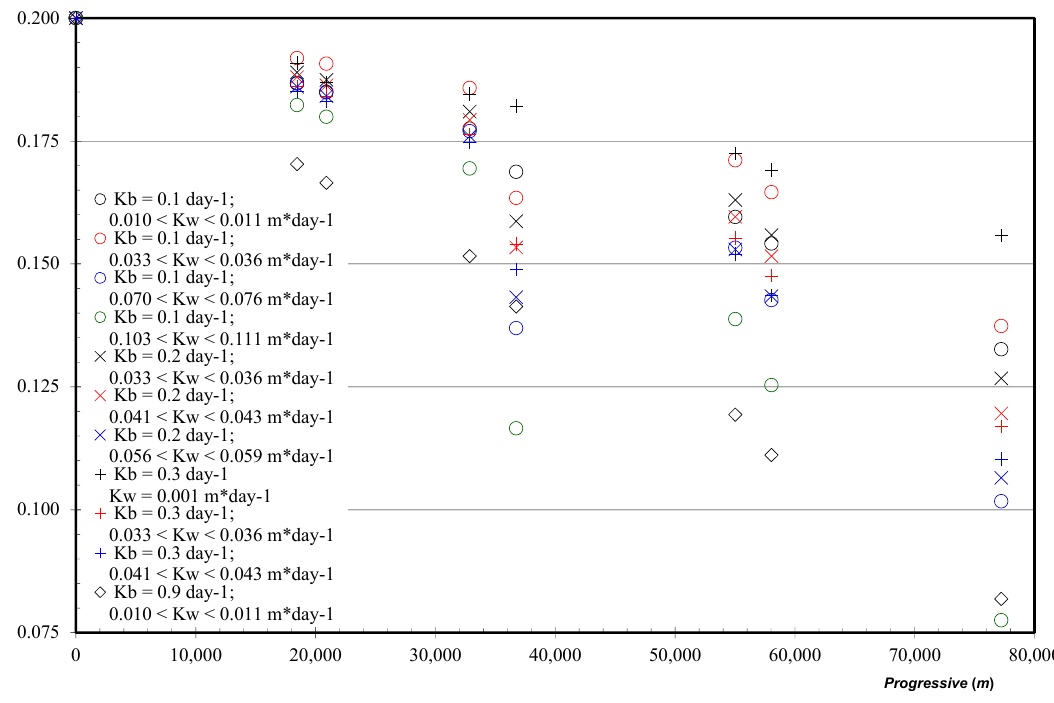
Figure 5. Values of chlorine calculated by the model.